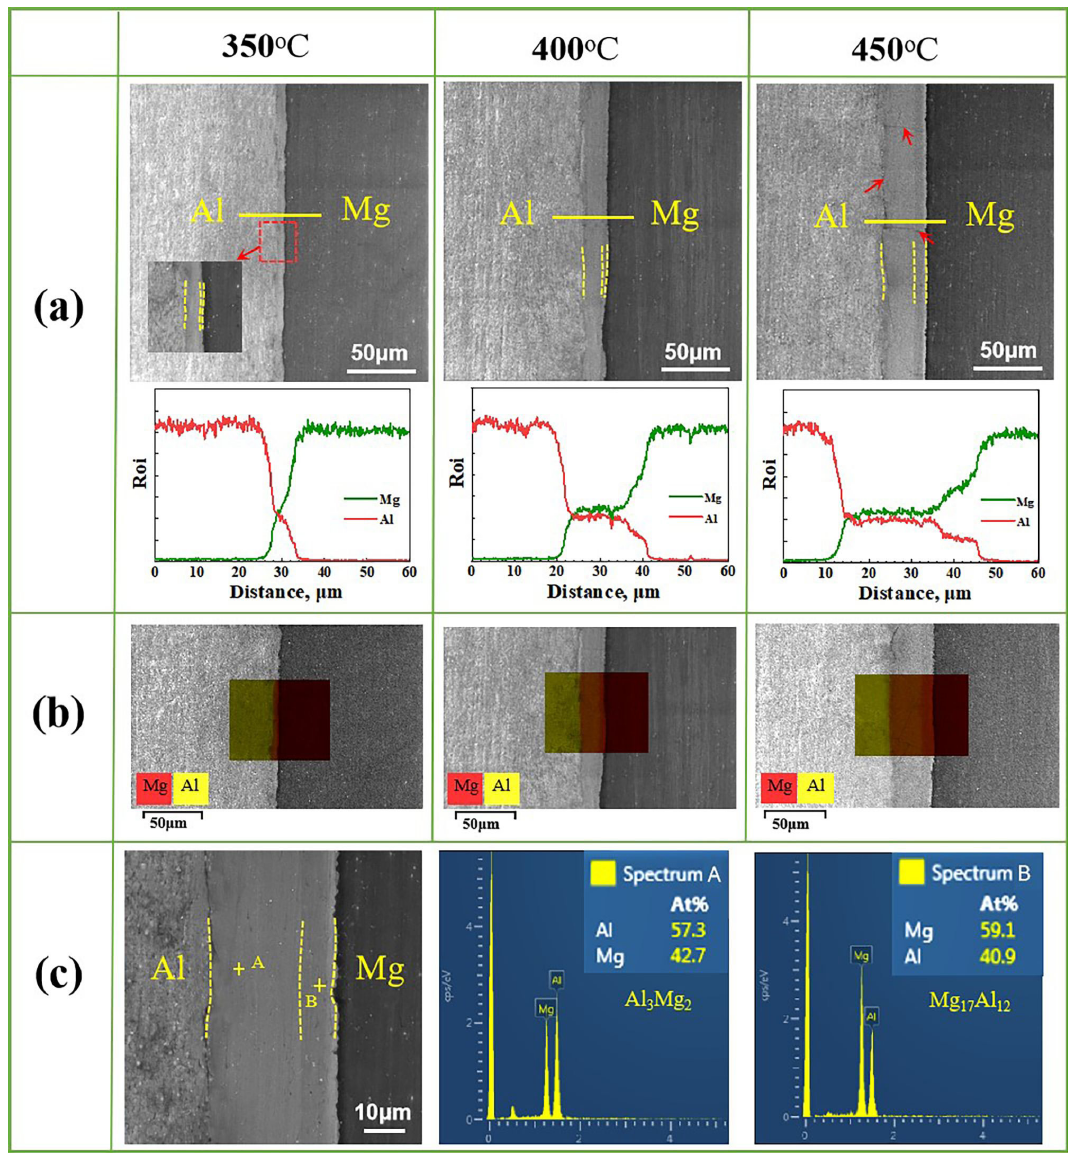
Figure 6. The SEM images of Al/Mg interface in LMCs: (a) the EDS line analysis and (b) the EDS map analysis at different temperatures, (c) the EDS point analysis at 450 o